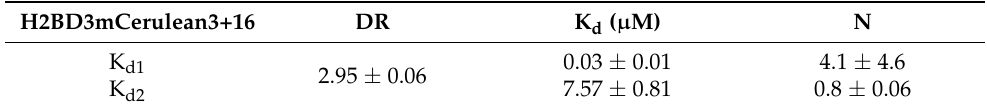
Table 1. In situ properties of H2BD3mCerulean3+16. DR, dynamic range; K d , dissociation constant; N, Hill constant. Data are presented as mean ± SEM of n ≥ 7